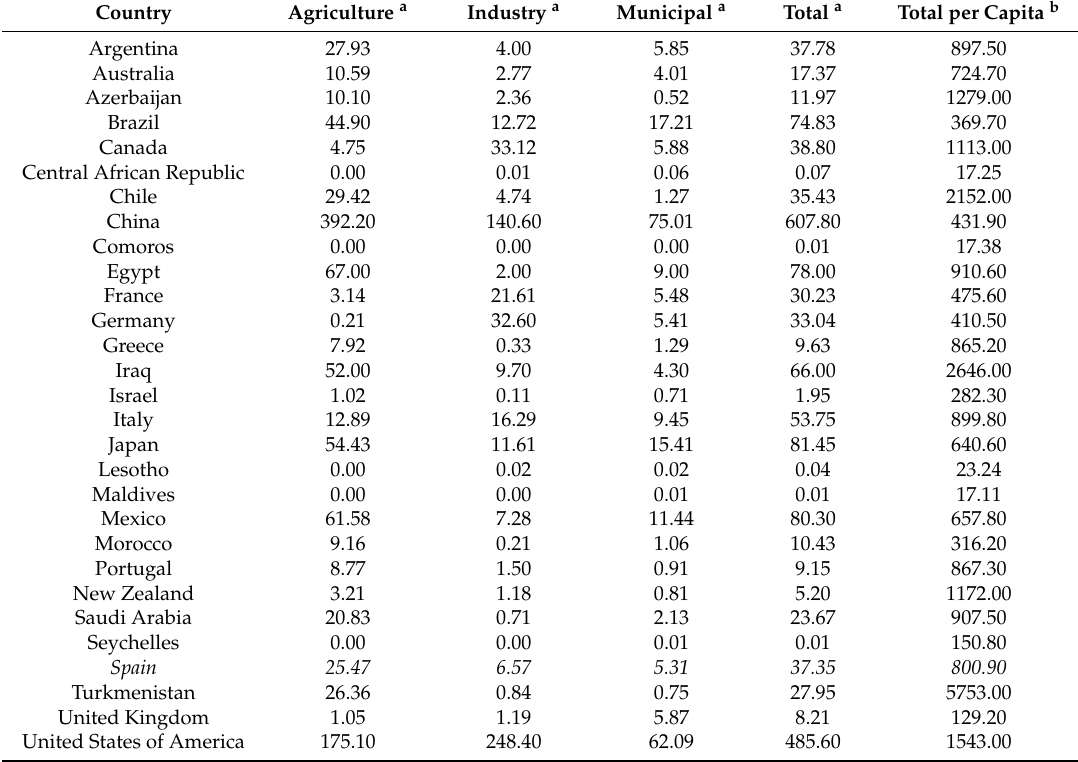
Table 1. Water withdrawal by sector and